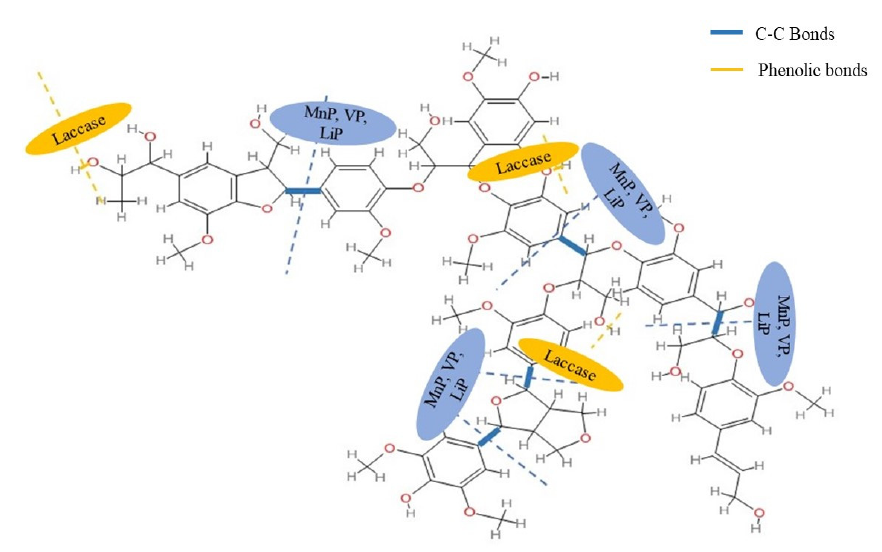
Figure 7. Role of lignolytic enzymes in lignin degradation.